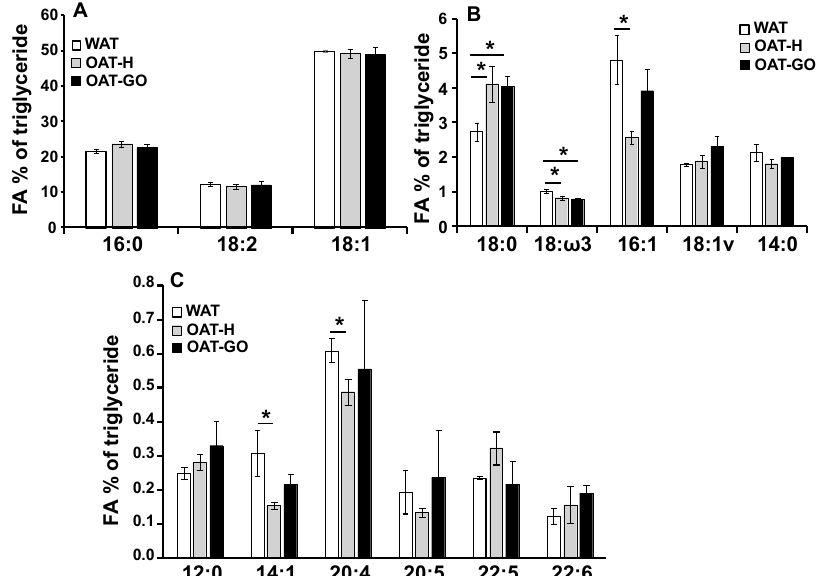
Figure 3. Depot specific fatty acid (FA) composition in OAT. Triglyceride composition of paired ex vivo fat tissues of OAT-H and WAT from three female individuals, also 3 unpaired ex vivo OAT-GO from female GO patients were analyzed by gas chromatography. Data presented as FAs percentage